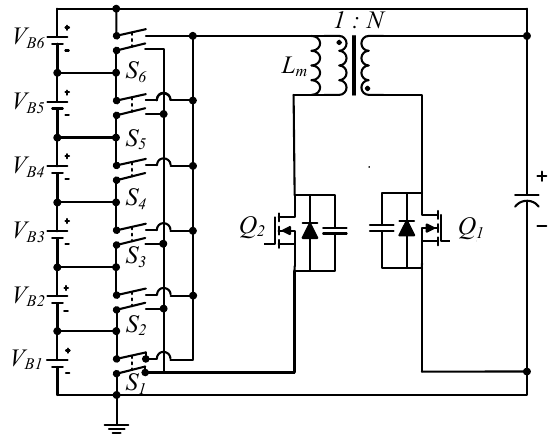
Figure 3. Diagram of active cell balancing circuit based on bidirectional flyback converter.